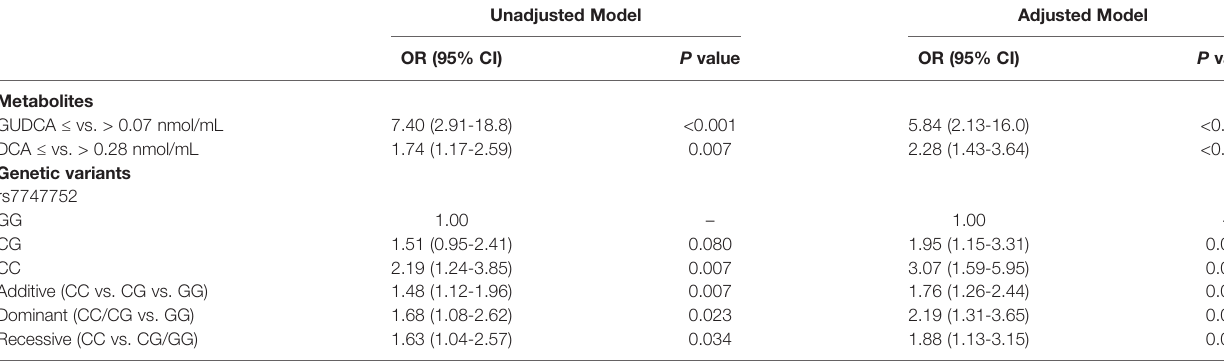
TABLE 2 | Odds ratios of the CDKAL1 rs7747752 and bile acid metabolisms for increased risk of gestational diabetes